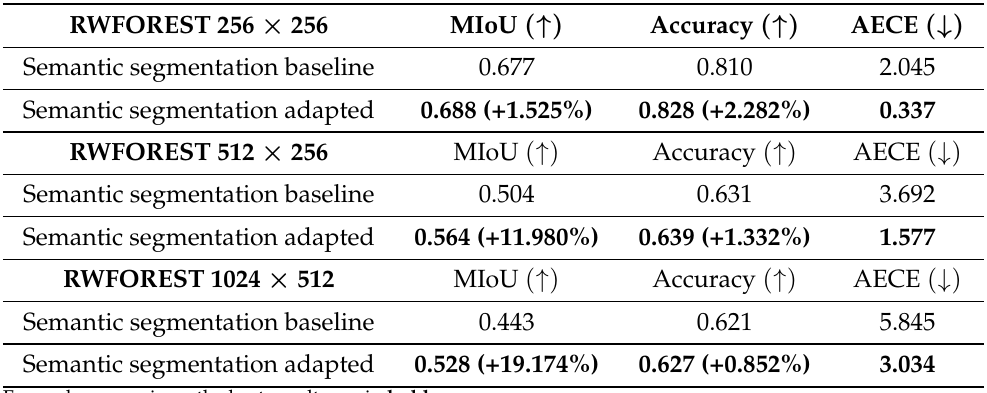
Table A1. Comparison of adapted and baseline semantic segmentation networks on RWFOREST 256 × 256, RWFOREST 512 × 256, and RWFOREST 1024 ×